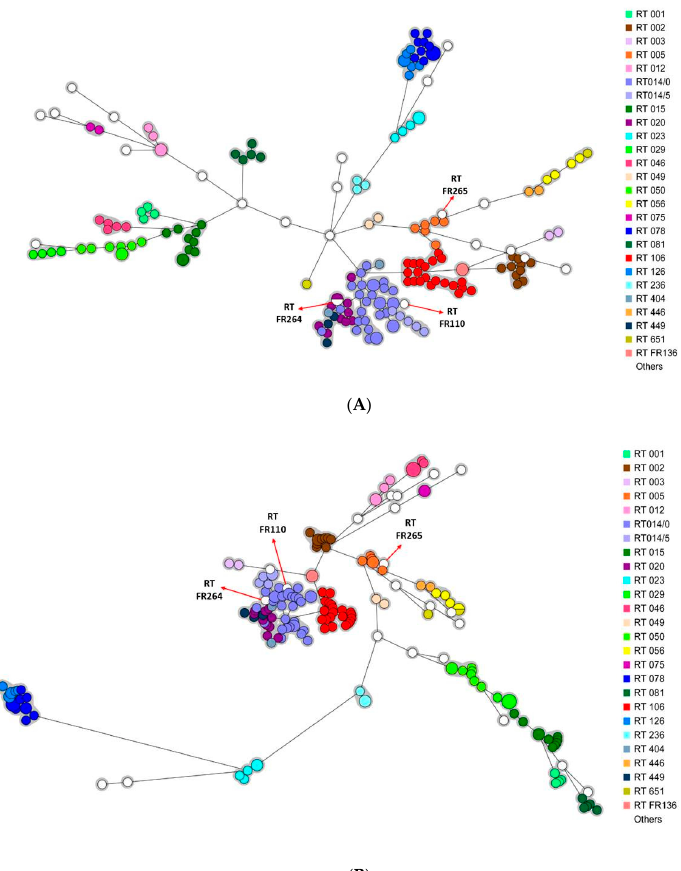
Figure 2. Minimum spanning trees including all isolates (n = 191). Each color represents a PCR- ribotype (26 different colors). The white color corresponds to PCR-ribotypes including only one isolate (n = 22). A circle represents an isolate, the size of the circle being proportional to the number of identical isolates. ( A ) wgMLST analysis. The grey area represents a clonal complex ( ≤ 20 different alleles). ( B ) cgSNP analysis. The grey area represents a clonal complex ( ≤ 10 different